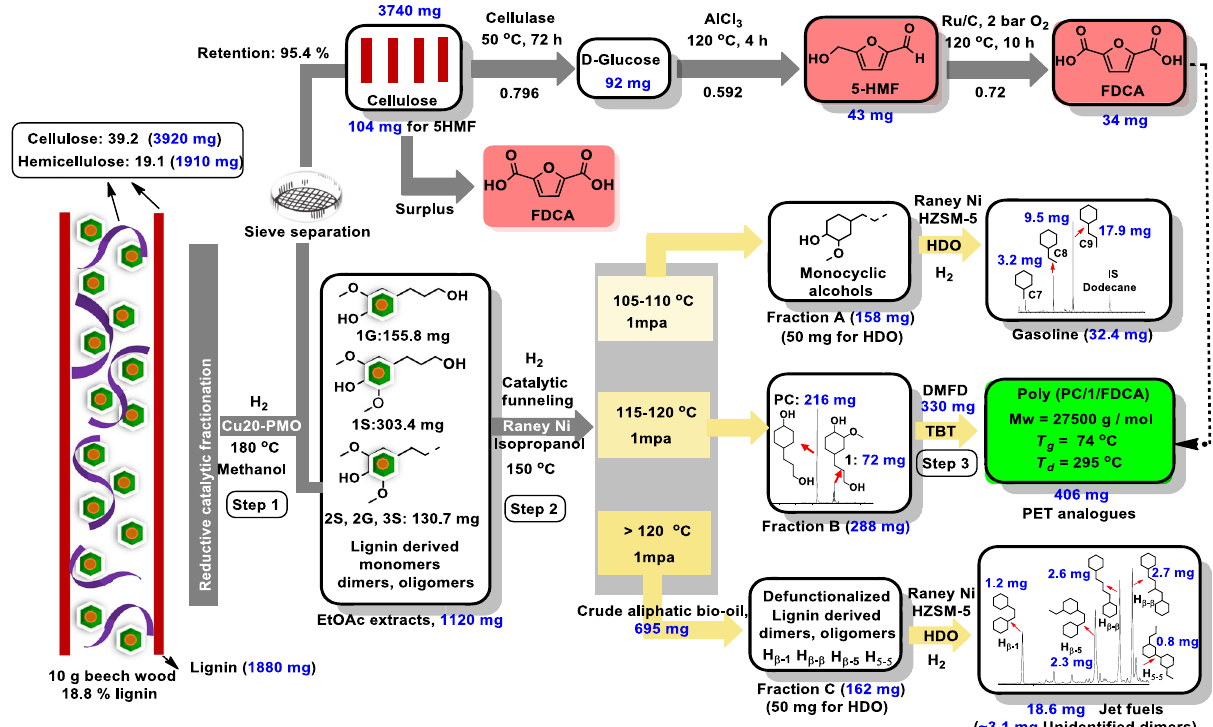
Fig. 5 Comprehensive catalytic protocol for beech wood biore fi nery for producing PET analogues and fuels. Step 1: RCF of beech wood over Cu20-PMO catalyst (10 g beech wood, 2 g Cu20-PMO catalyst, 120 mL methanol, 40 bar H 2 , 180 °C, 18 h) gives crude lignin oil and residual carbohydrates; Removal of impurities gives EtOAc extracts; Step 2: Catalytic funneling of EtOAc extracts (1120 mg EtOAc extracts, 2 g wet Raney Ni catalyst, 30 mL isopropanol, 150 °C, 12 h) delievers a mixture of crude aliphatic oil which is puri fi ed by distillation under 1 mpa at (100 – 120 °C) to deliver three Fractions (A (100 – 105 °C), B (115 – 120 °C) and C (>120 °C)). PET analog synthesis: Reaction conditions (288 mg Fraction B, 330 mg DMFD (1.79 mmol), 1 mol%